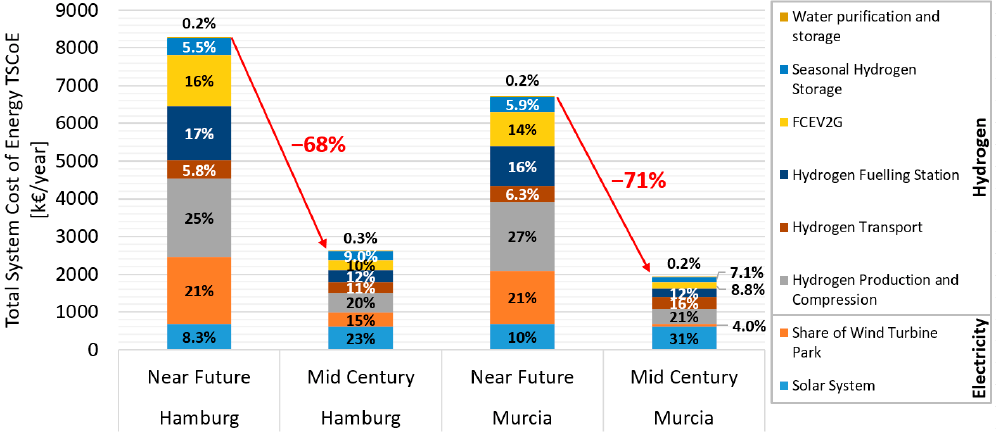
Figure 7. Total system cost of energy (TSCoE) for the component categories in the Near Future and Mid Century scenarios for Hamburg and Murcia. The subsystems are grouped into “Hydrogen” and “Electricity”.